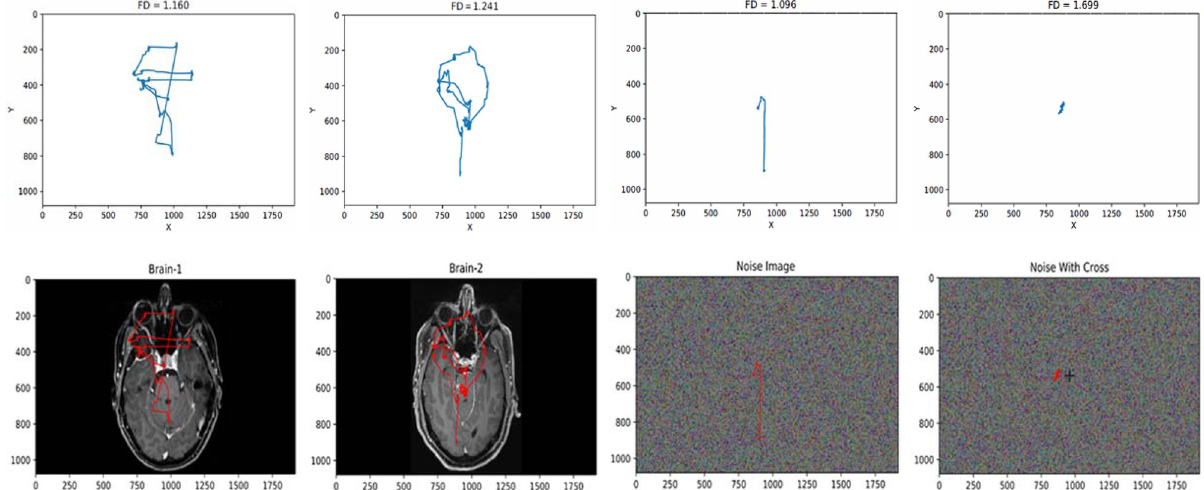
Fig 3. Some sample scanpaths with fractal dimension (FD) values and corresponding stimuli explaining the relation between FD values and geometric complexity.